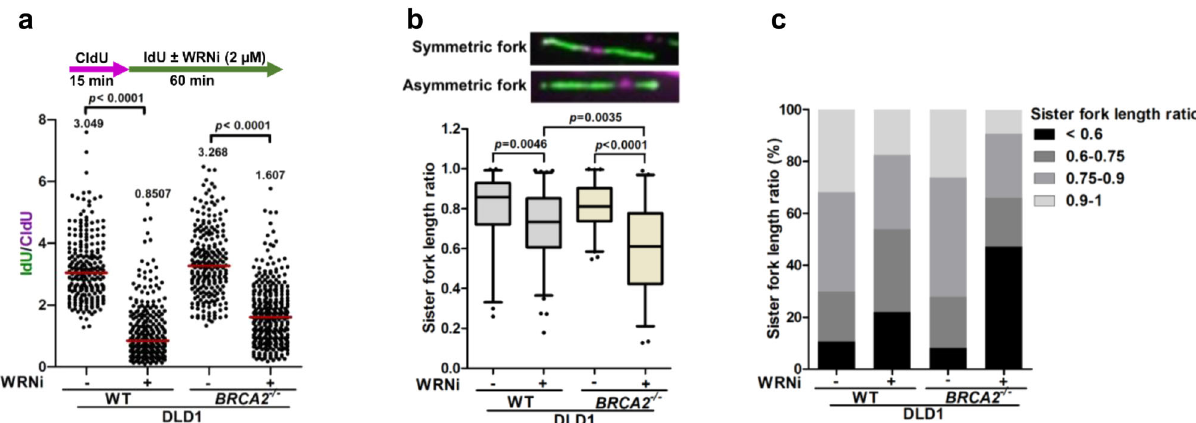
Fig. 4 WRN helicase inhibitor causes replication fork stalling. a (Upper panel) Schematic of the fork progression assay in WT and BRCA2 − / − DLD1 cells upon WRNi treatment. (Lower panel) Scatter dot plot showing IdU/CldU ratios in individual genotypes treated or untreated with the WRNi. Representative of n = 3 independent experiments; p -values ( p < 0.0001, p < 0.0001) were derived from n ≥ 200 DNA fi bers using two-tailed Mann – Whitney test. b (Upper panel) Representative DNA fi bers depicting symmetric and asymmetric bi-directional replication forks. Length of the two sister forks (IdU) emanating from a single bidirectional origin (CldU) was measured from individual bidirectional (green-purple-green) fork structures scored from the experiment as described in a . (Lower panel) Boxplot (5 – 95th percentile) of sister fork (SF) ratios (short to long IdU tract length ratio) in WT and BRCA2 − / − DLD1 cells treated or untreated with WRNi. Bounds of the box represent 25th – 75th percentile, middle horizontal lines show the median, whiskers indicate 5th – 95th percentiles. Representative of n = 3 independent experiments; p -values ( p = 0.0046, p = 0.0035, p < 0.0001) were derived from n ≥ 40 bidirectional forks using two-tailed Mann – Whitney test. c Bar graph showing percent distribution of sister fork length ratios. In a , horizontal red bars indicate the median of IdU/CldU ratios; median IdU/CldU values are indicated; purple and green colors indicate CldU and IdU labeling, respectively. Source data are provided as a Source Data (Supplementary Fig. 6d). NSC617145-induced chromatin binding